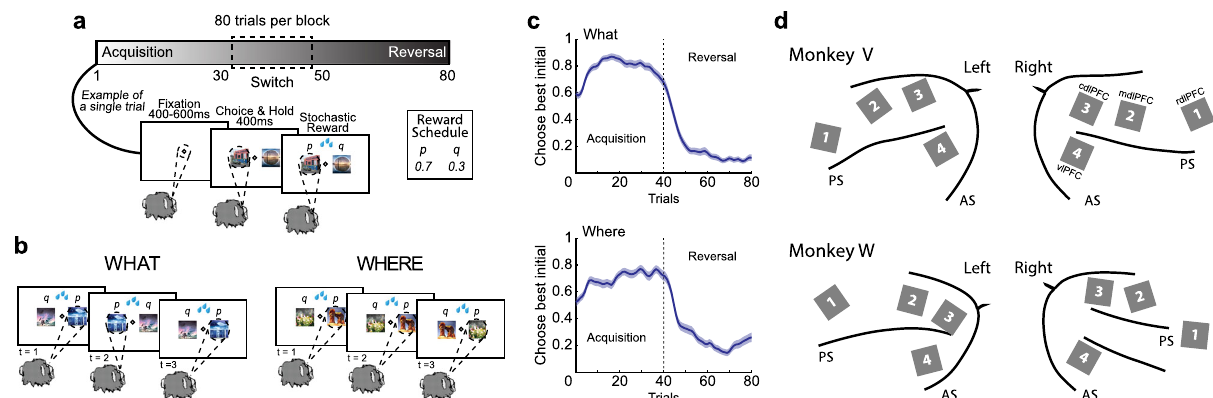
Fig. 1 Reversal learning task, behavior, and array maps. a Block structure of the task and single-trial behavior. In each trial, the animals fi rst acquire the central fi xation. Two objects are then shown on the left and right sides of the fi xation dot. The animals make an eye movement to acquire one of the objects/locations and are then rewarded based on the block type and the reward probability assigned to that object/location. b Each block is either a What block, where rewards are associated with objects or a Where block, where rewards are associated with locations. The block type is not indicated and it is randomly interleaved. c Choice behavior for two monkeys. The fraction of times that the monkeys chose the initially higher rewarded visual stimulus option in What and Where blocks. Solid lines show the means, and the shaded regions show the mean ± SEM, which were computed across all sessions. The vertical dashed line shows the average reversal point. Data from two monkeys, n = 8 sessions. d Schematic of array locations. Four Utah arrays (indicated by gray squares) were implanted in the LPFC of each hemisphere for each monkey. Array 1 was located in the rostral dorsal LPFC (rdlPFC), array 2 was located in the middle dorsal LPFC (mdlPFC), array 3 was located in the caudal dorsal LPFC (cdlPFC), and array 4 was located in the ventral LPFC (vlPFC). Monkey W had an unusual sulcal pattern in the right hemisphere. AS arcuate sulcus, PS principal sulcus. Source data are provided as a Source Data fi